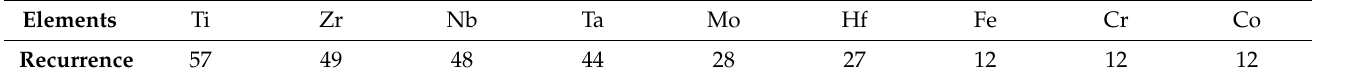
Table 2. Recurrence of elements in bioHEAs compositions evaluating 49 selected